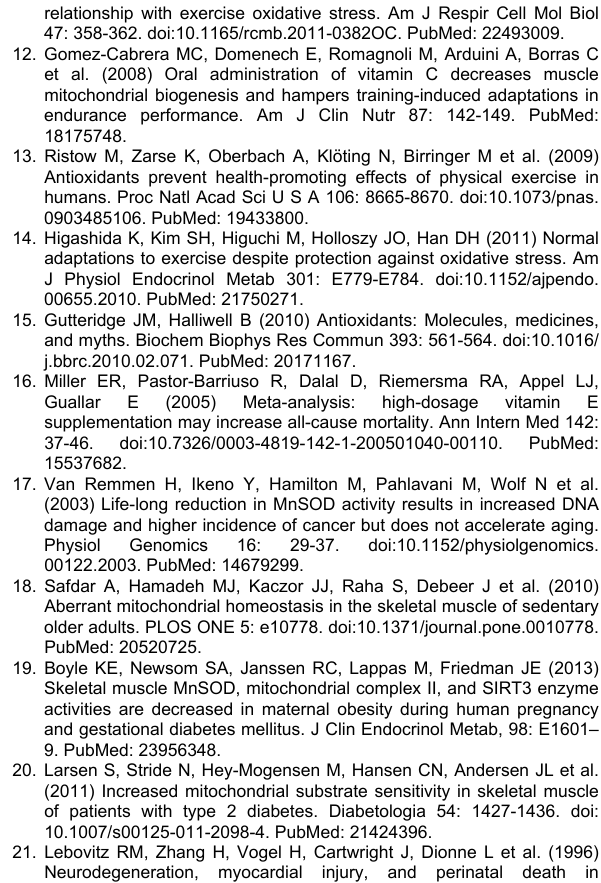
Figure S2. Non-significant mitochondrial oxidative damage analysis. Densitometry and immunoblots of (A) 4- Hydroxynonenal (4HNE) normalized to VDAC and (B) protein carbonyls in isolated mitochondria from quadriceps femoris muscle in Sod2 +/+ and Sod2 +/- SED and EX mice. Data are mean±SE. NS, non-significant.